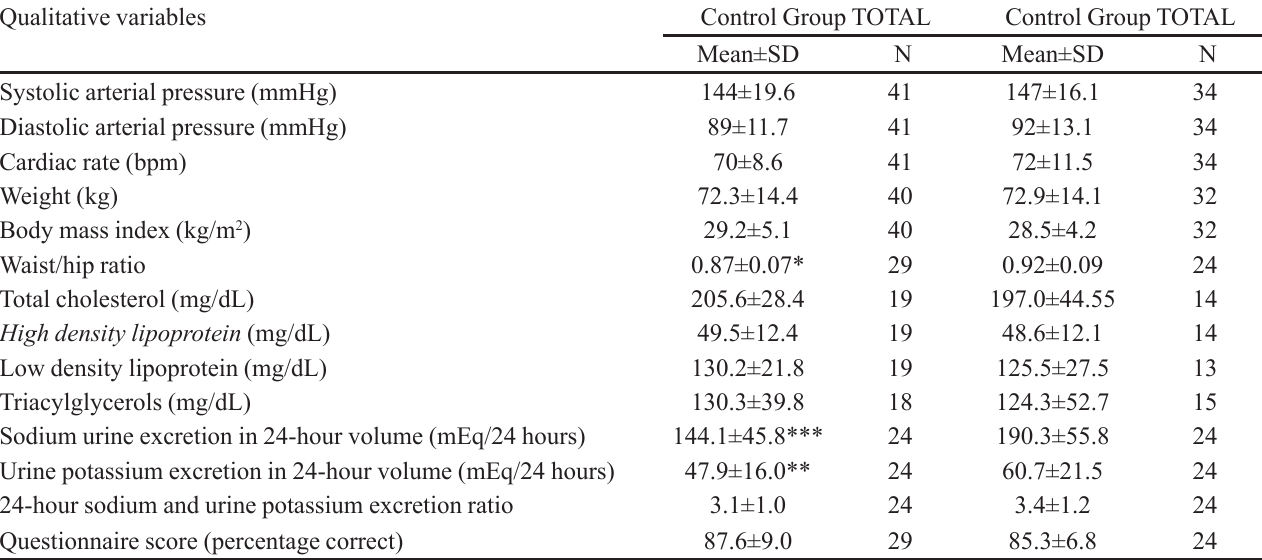
TABLE II – Baseline values for Quantitative variables in the total experimental and control groups Qualitative